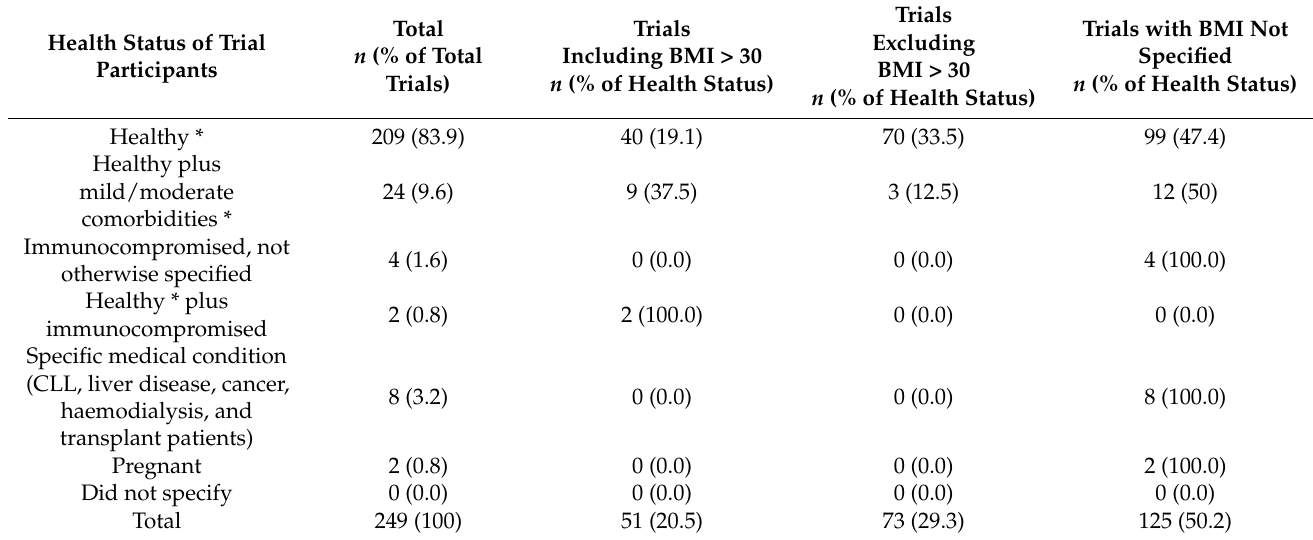
Table 6. Inclusion and exclusion by health status of participants with BMI > 30 in COVID-19 vaccine trials.